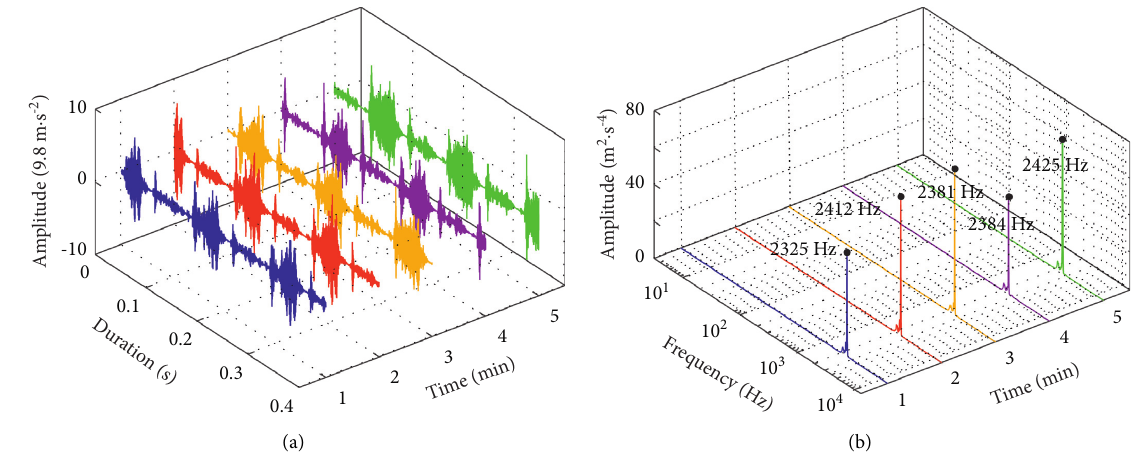
Figure 6: The waveform and power spectrum of squeal signals under dry friction at different moments: (a) the time-domain waveform; (b) the power